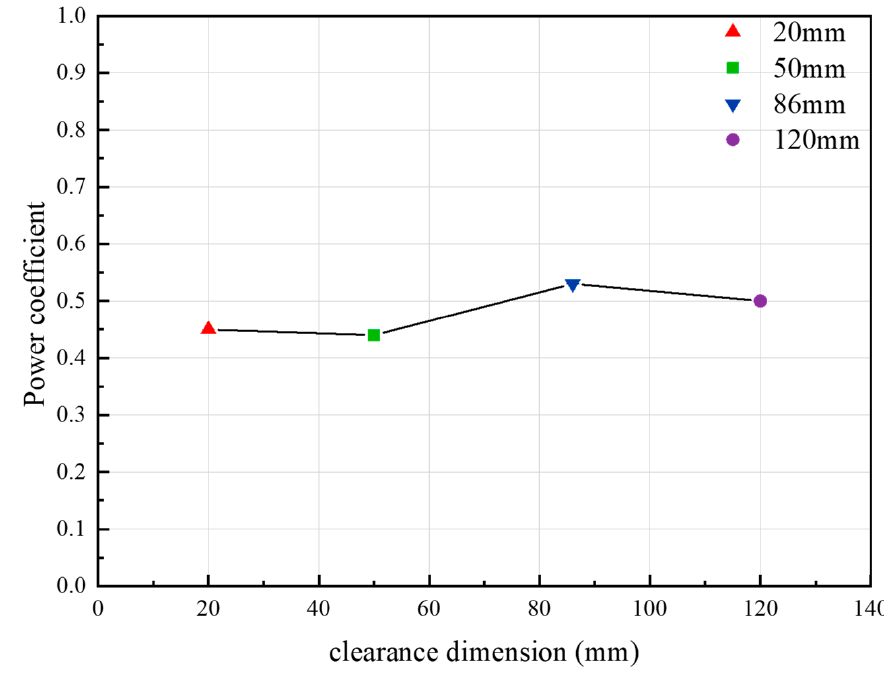
Figure 5. Comparison of efficiency among different clearance dimensions.